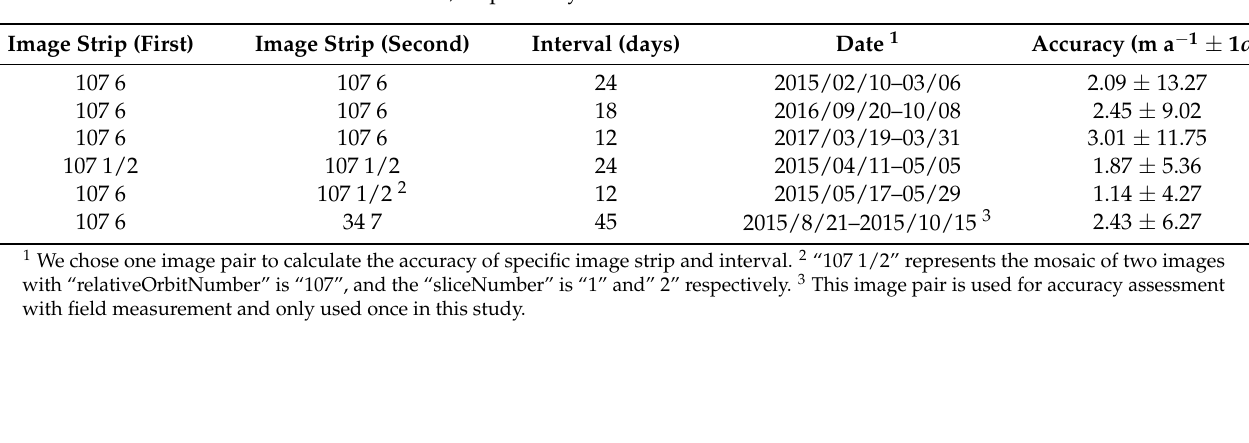
Figure 2. Flowchart of the processing methodology performed with the use of Google Earth Engine. Table 3. Averaged surface velocities (m a − 1 ) and standard deviation ( ± 1 σ ) of each image strip and time interval. The strip numbers of the two images in an image pair are given, and the two numbers in this item represent “relativeOrbitNumber” and “sliceNumber” of Sentinel-1 GRD data,